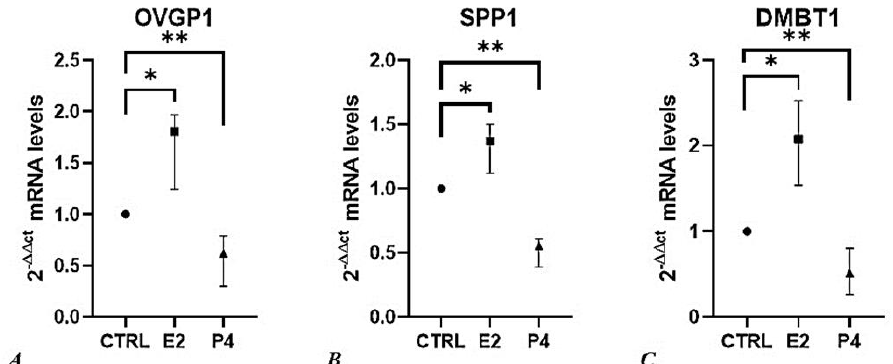
Figure 6. The effect of progesterone and estradiol on relative gene expression (2 − ∆∆ Ct ) of ( A ) OVGP1 , ( B ) SPP1 , and ( C ) DMBT1 . Results are represented as median value with 95 % confidence interval. Data were analyzed using the Kruskal-Wallis test. For each qPCR analysis, each sample was per- formed in triplicate, and values were normalized to the GAPDH endogenous reference gene. P4, Progesterone; E2, Estradiol; ** = p < 0.001, * = p < 0.01.